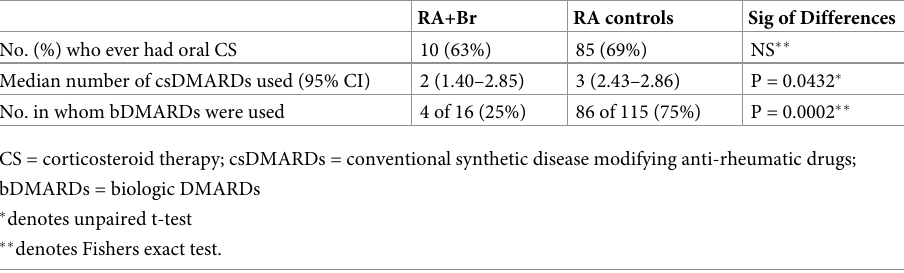
Table 2. Different frequencies of usage of csDMARDs and bDMARDs in RA+Br and RA without bronchiectasis. RA+Br RA controls